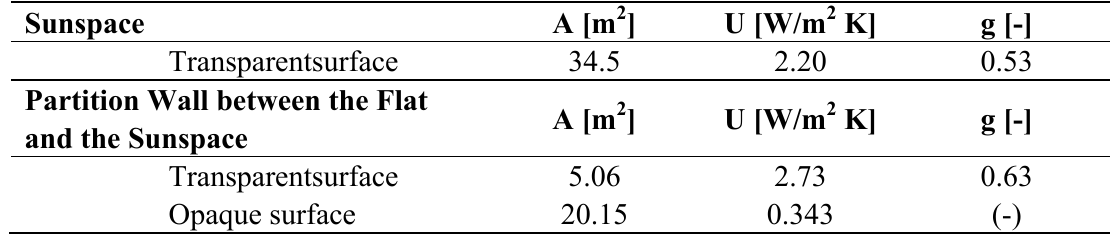
Table 4. Thermal and geometrical features of the sunspace and of the partition